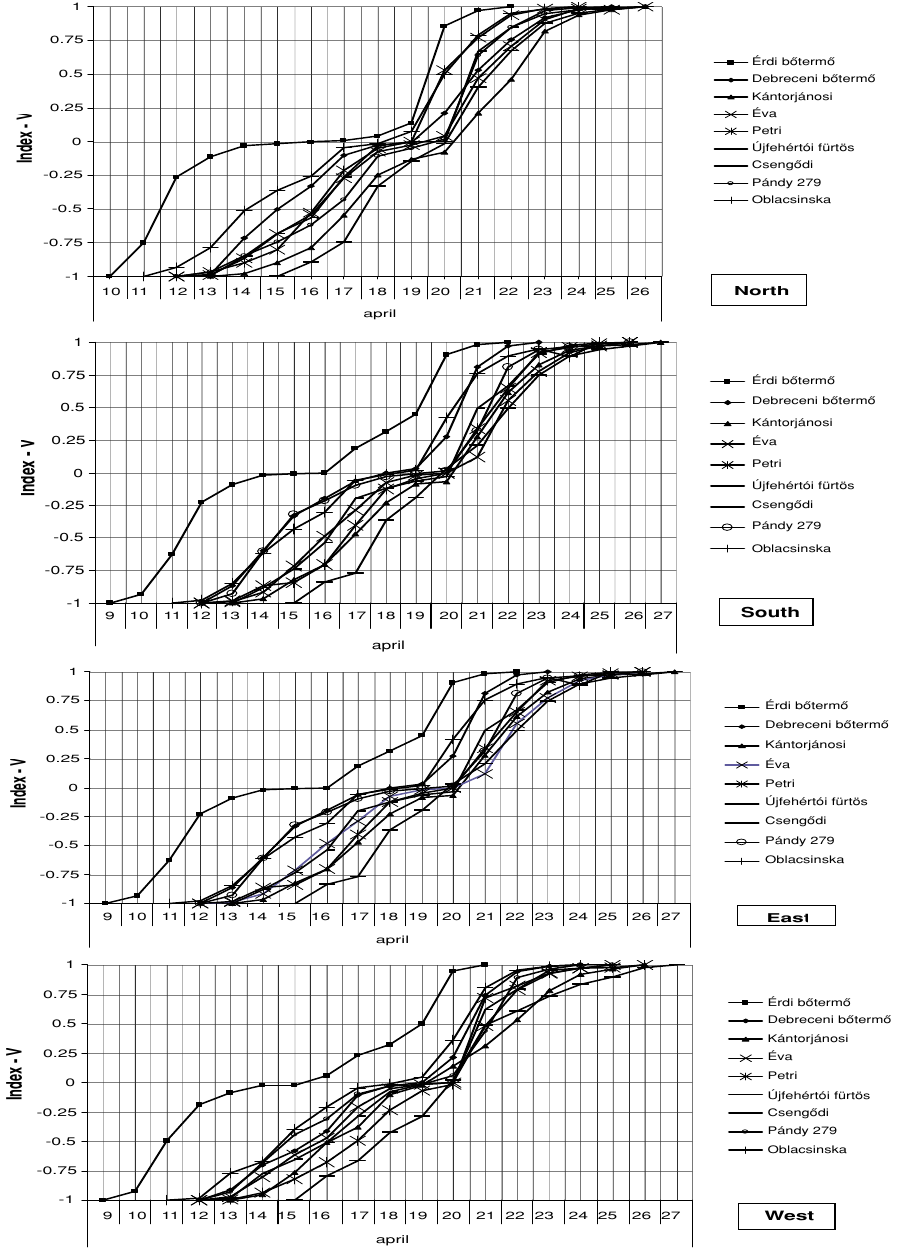
Figure 2. The V- indices of sour cherry cultivars (Hungary,